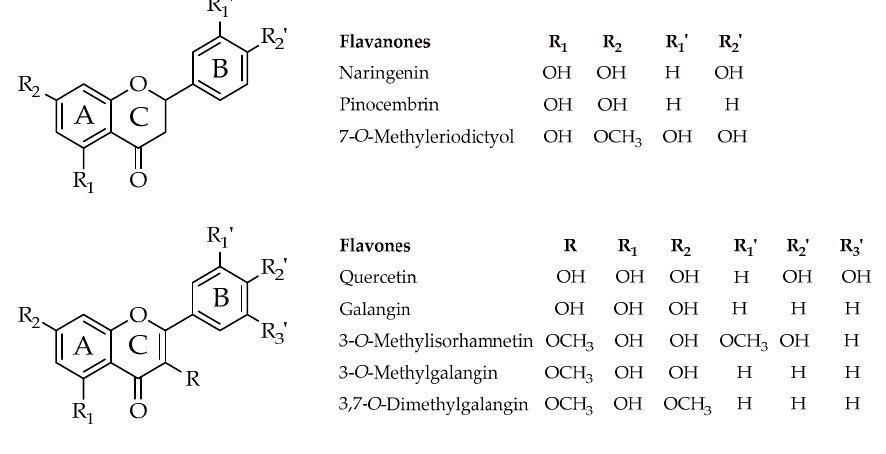
Figure 1. Flavonoids used in this study.